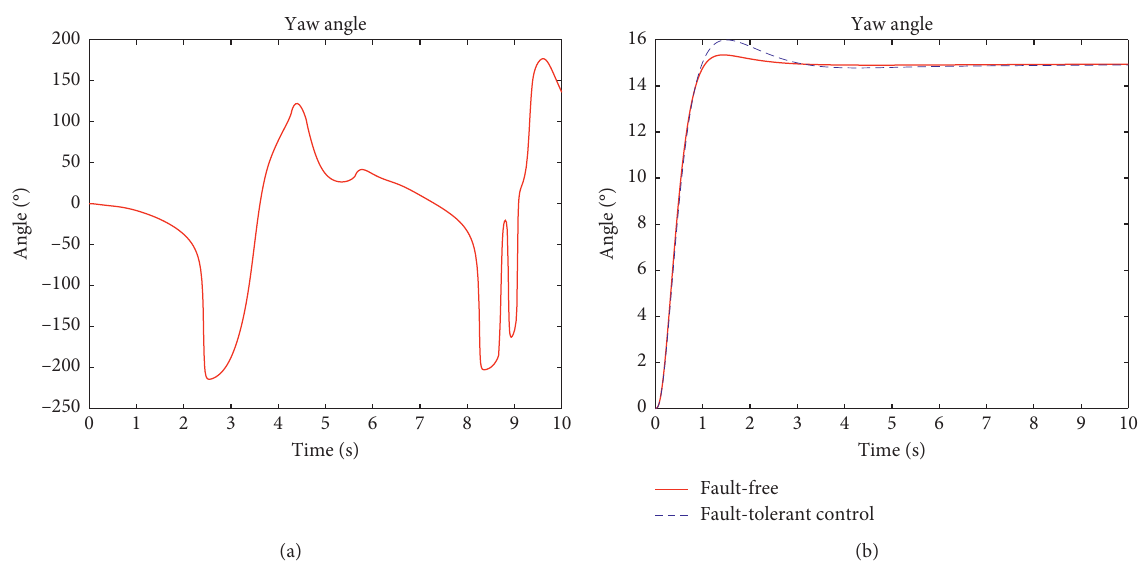
Figure 5: Comparison diagram of the yaw angle before and after fault-tolerant control. (a) Non-fault-tolerant control. (b) Fault-tolerant